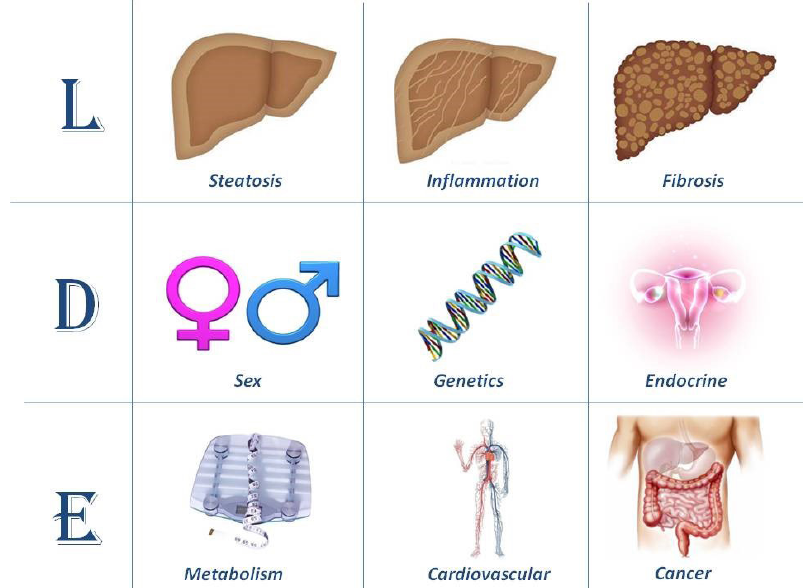
Figure 1. The LDE system [ 2, 19]. In its essence, the LDE system requires clarification of nine criteria that should be recorded to better characterize cohorts of patients. The prefix “L” for “Liver” aims at analytically illustrating the severity of liver involvement based on either non-invasive or histological assessment. Cirrhosis and/or HCC should be declared here. The central part of the LDE system is “D” for “determinants”. Among these, sex and reproductive status must be emphasized and genetic determinants should also be acknowledged, if available. Type 2 diabetes/insulin resistance and obesity should always be confirmed/excluded. Hypothyroidism should also be evaluated. Other endocrine derangements, such as polycystic ovary syndrome, growth hormone deficiency and hypogonadism (in both sexes), should always be declared. The suffix “E” for “extra-hepatic” reports information regarding non-hepatic, i.e. systemic manifestations of